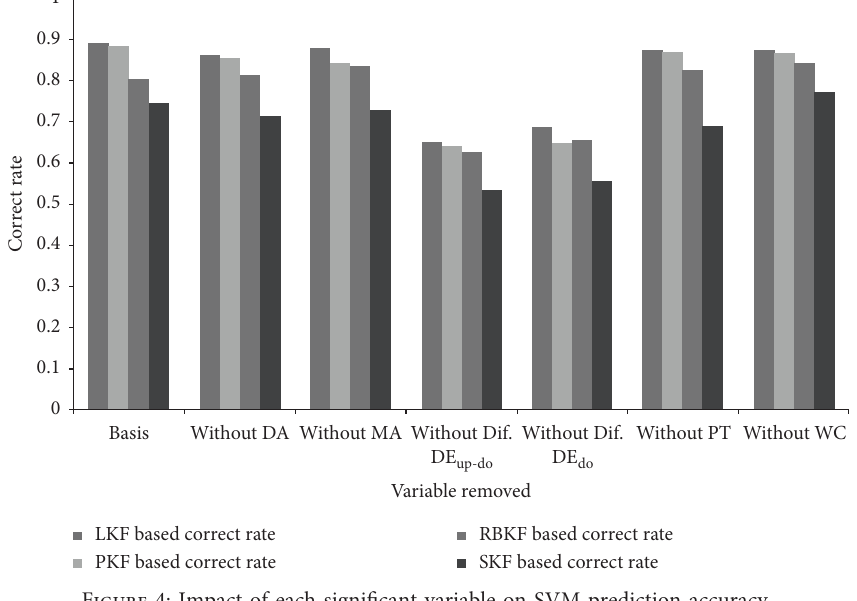
Figure 4: Impact of each significant variable on SVM prediction accuracy. Table 3: Prediction performances of real-time crash prediction